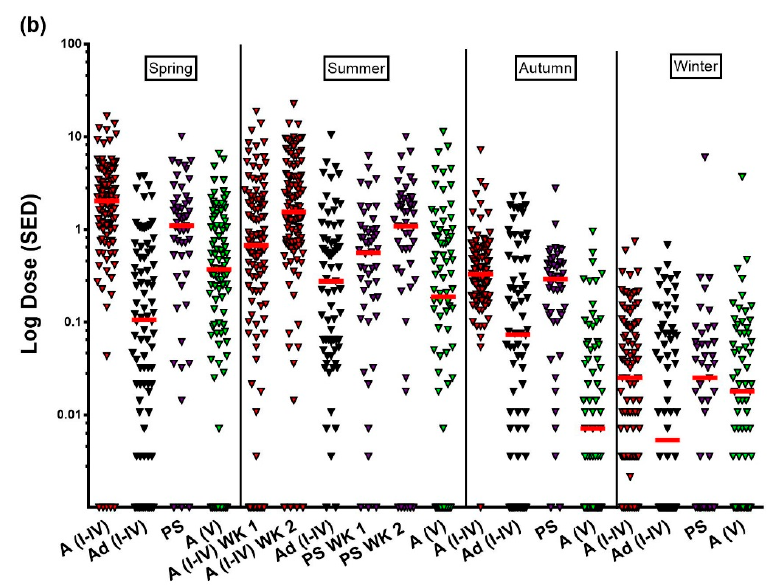
Figure 1. Dose of UVR received (SED) as measured by polysulphone dosimeter badges worn by volunteers: ( a ) Weekday data, ( b ) Weekend data. Red bars show the median for the group. A: adult; Ad: adolescent; PS: photosensitive; WK: week; I–IV and V refer to volunteer skin types.